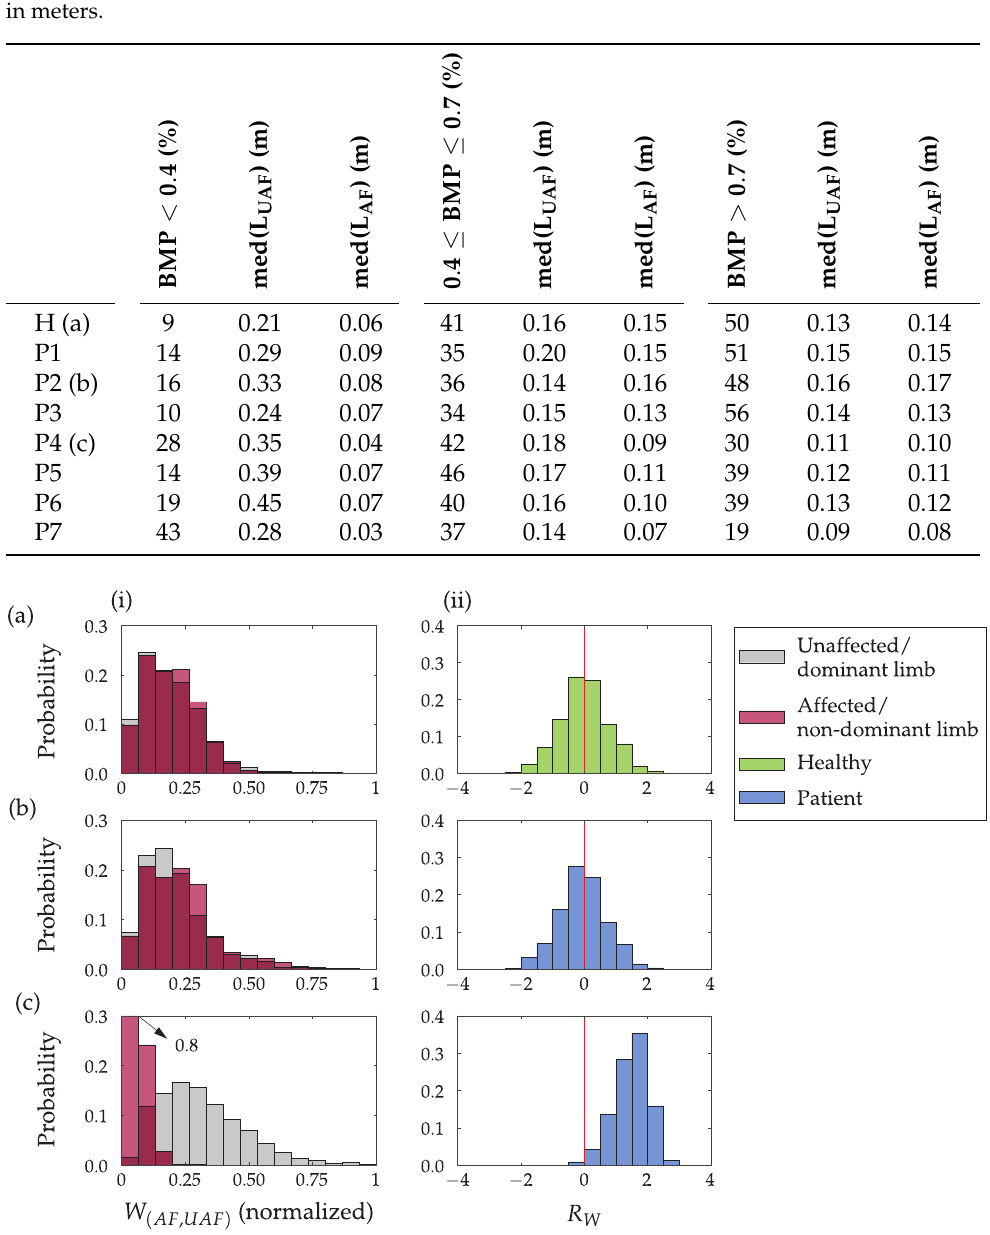
Figure 12. Probability distribution of the normalized activity level for the unaffected (dominant) and affected (non-dominant) upper limbs W ( AF , UAF ) ( i ) and the ratio of muscle activities R W ( ii ), for a healthy person ( a ) and two stroke patients ( b , c ). The red vertical line marks the boundary between the dominant (unaffected) and non-dominant (affected) upper